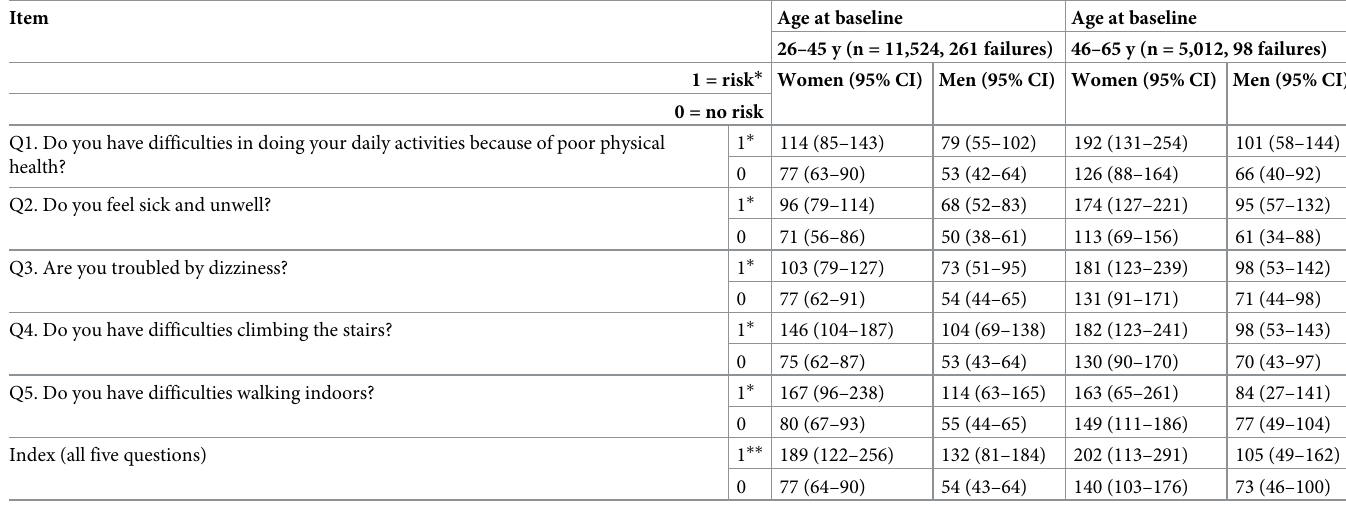
Table 2. Age-adjusted incidence rates per 100,000 person years with 95% confidence intervals (95% CI) for hip fractures by sex.